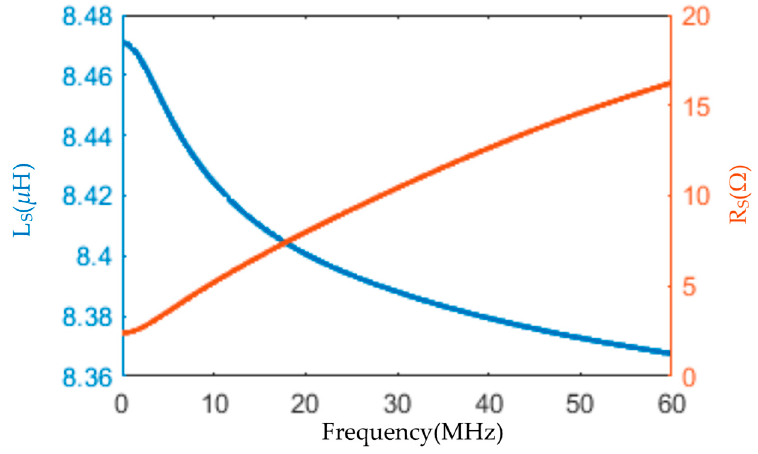
Figure 15. The change in inductance with frequency is small, and the resistance increases gradually with the increase in frequency.